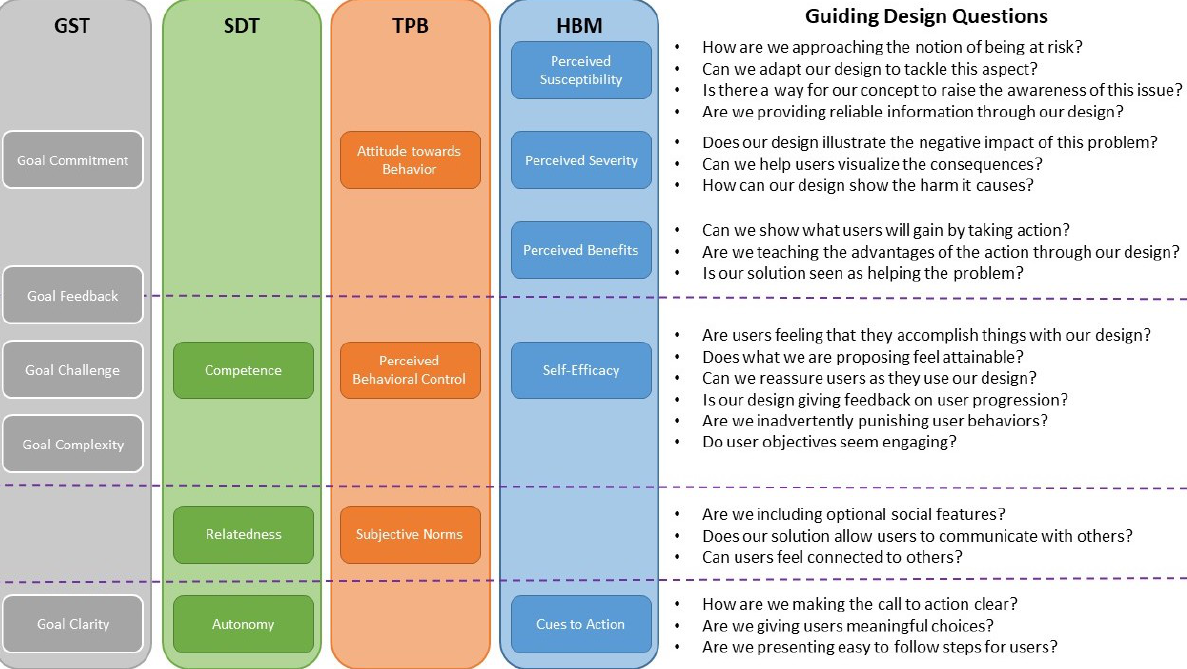
Figure 4. Guiding design questions. GST: goal-setting theory; SDT: self-determination theory; TPB: theory of planned behavior; HBM: health belief